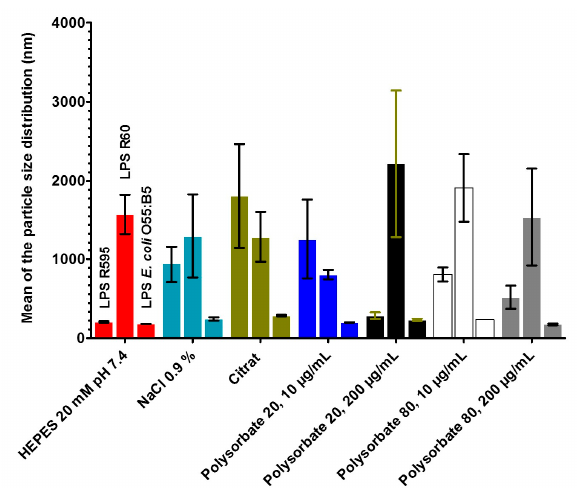
Figure 5. Effect of the formulation on the aggregate size of LPS. The figure shows the particle size for seven different preparations. For each preparation, LPS aggregates are shown as LPS R595 (first bar), LPS R60 (second bar), and LPS E. coli O55:B5 (third bar). The error bar results from twofold measurement of TNF- α in the ELISA.